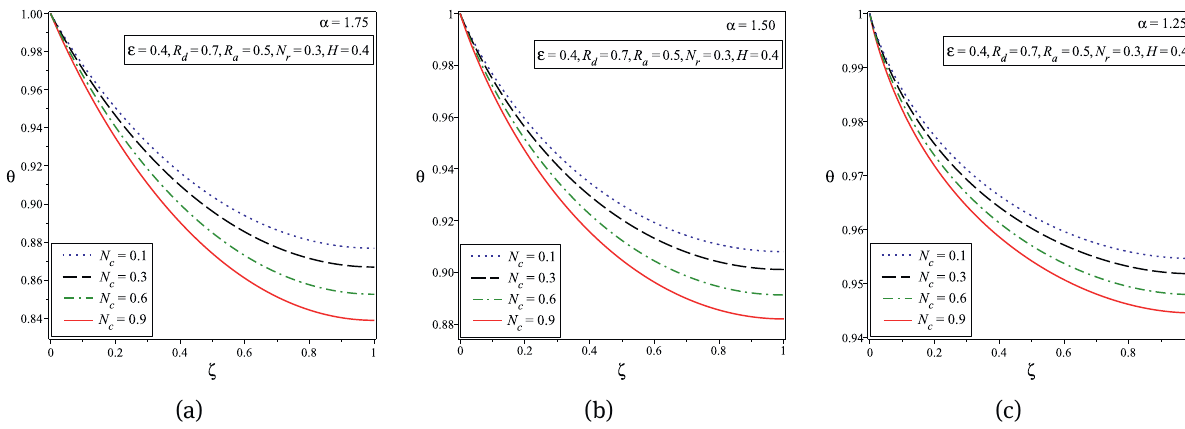
Fig. 6: The ADSTM solutions for a different value of N c and for (a) α = 1.75 (b) α = 1.5 (c) α = 1.25 .